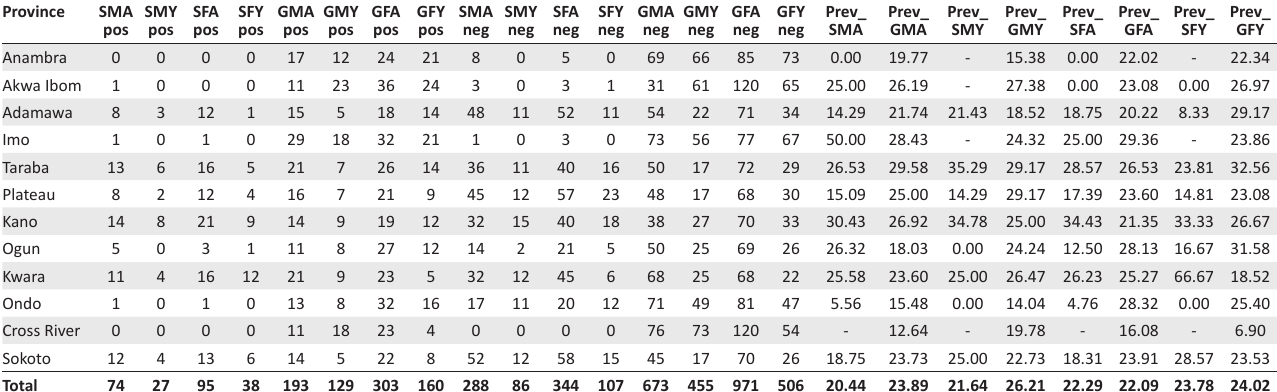
TABLE 3-A1: Peste des petits ruminants virus seroprevalence data based on category of small ruminants in Nigeria,